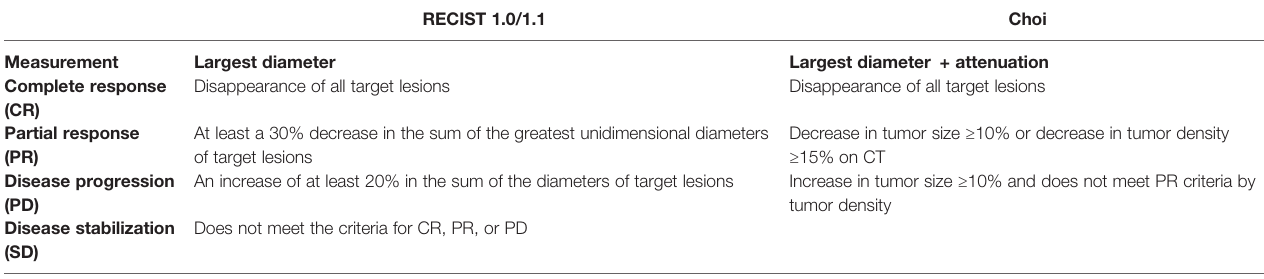
TABLE 1 | De fi nition of radiological responses to therapy according to RECIST 1.1 and Choi criteria. RECIST